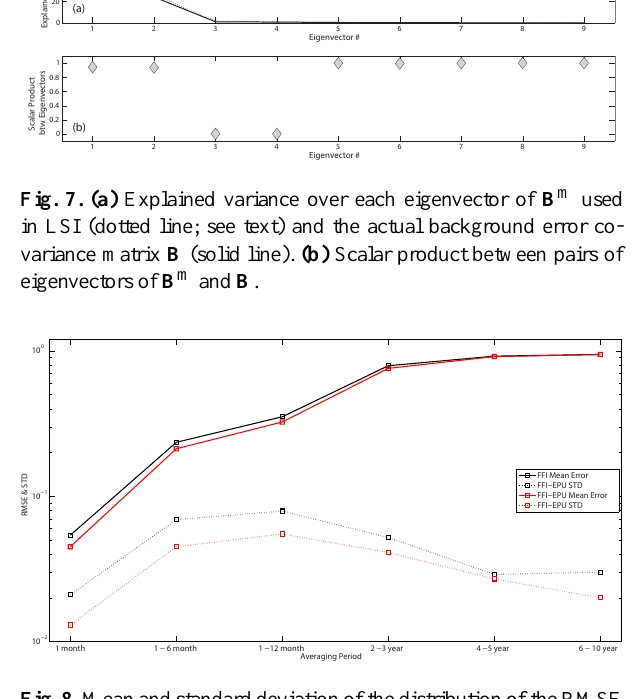
Fig. 8. Mean and standard deviation of the distribution of the RMSE relative to the 109 configurations, for FFI (black) and FFI-EPU (red), as a function of the averaging forecast period.